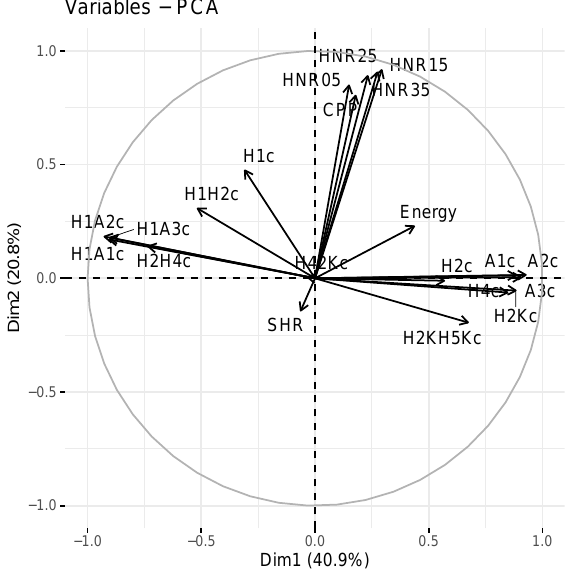
Figure 3. The loadings for PC1 and PC2 of all acoustic features. The most correlated cues for PC1 are A2*, H1*–A2*, H1*–A1*, A3*, and H1*–A3*; the most correlated cues for PC2 are HNR15, HNR25, HNR35, HNR05, and